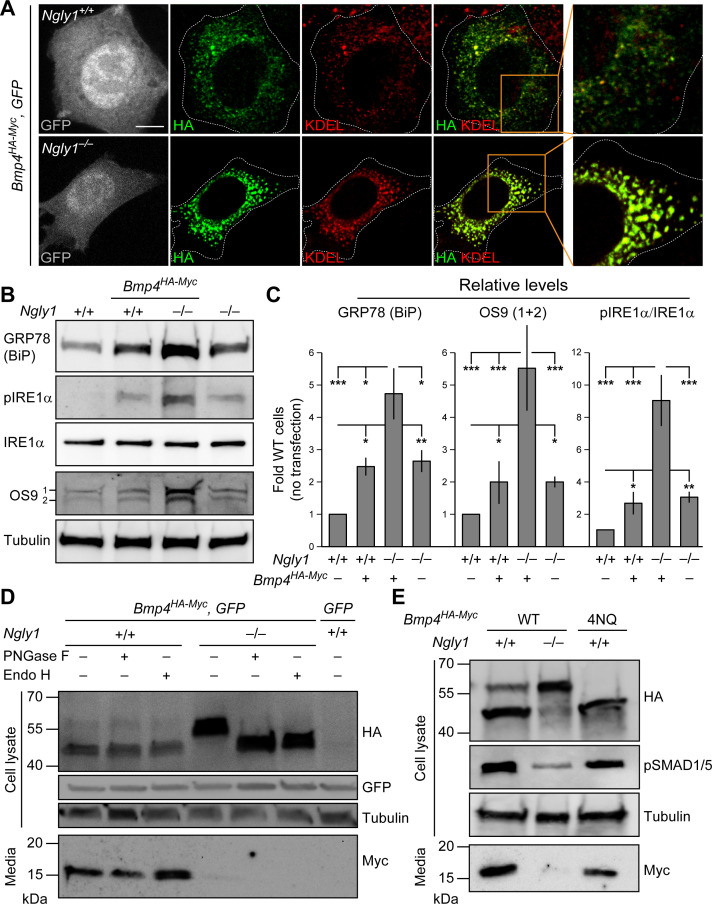
In Ngly1 mutant MEFs, BMP4 retains N-glycans and is trapped in the ER.(A) Confocal sections of WT and Ngly1 mutant MEFs co-transfected with Bmp4HA-Myc and GFP (for transfection efficiency) and stained for HA (to mark BMP4HA-Myc, green) and the ER marker KDEL (red). HA-tagged BMP4 almost fully colocalizes with KDEL/GRP78 in Ngly1 mutant cells, suggesting impaired exocytic trafficking. Scale bars, 10 μm. n = 8 biologically independent samples. (B,C) Western blot with α-KDEL antibody, which marks GRP78 (BiP), and α-pIRE1α, α-IRE1α, and α-OS9 antibodies on protein lysates from WT and Ngly1 mutant MEFs with or without Bmp4HA-Myc transfection. ER stress is induced in Ngly1–/– MEFs and is significantly enhanced upon Bmp4 transfection, likely due to the accumulation of misfolded BMP4. A representative image of three independent blots is shown. For each blot, the protein expression was normalized to tubulin and the value of Ngly1+/+ cells without transfection was set as 1. Two-way ANOVA with Tukey's multiple comparisons test was used for statistical analysis. Mean ± s.d. is shown. *p<0.05; **p<0.01; ***p<0.001; NS, not significant. (D) Western blot for HA and Myc on cell lysates and media from WT and Ngly1 mutant MEFs transfected with expression vectors for BMP4HA-Myc and GFP or GFP only (last lane). Protein extracts were treated with PNGase and Endo H for glycosylation profiling. Note the accumulation of a slow-migrating HA+ band in Ngly1–/– MEFs which returns to normal size upon treatment with both enzymes, indicating the retention of N-glycans on BMP4 upon loss of Ngly1. Note also the severe decrease in the level of active BMP4 (Myc blot) secreted by Ngly1–/– MEFs into the culture media. (E) Western blot for HA, pSMAD1/5 and Myc on cell lysates and media from WT MEFs transfected with an expression vector for BMP4HA-Myc-4NQ compared with WT and Ngly1–/– MEFs expressing wild-type BMP4HA-Myc. n = 3 independent biological samples. These data indicate that N-glycans on BMP4 are not necessary for its secretion (Myc) and signaling (pSMAD1/5) and that NGLY1 promotes BMP4 signaling by removing one or more N-glycans from BMP4, similar to their Drosophila counterparts.Figure 4—source data 1.Raw data and statistical analysis for panel C.